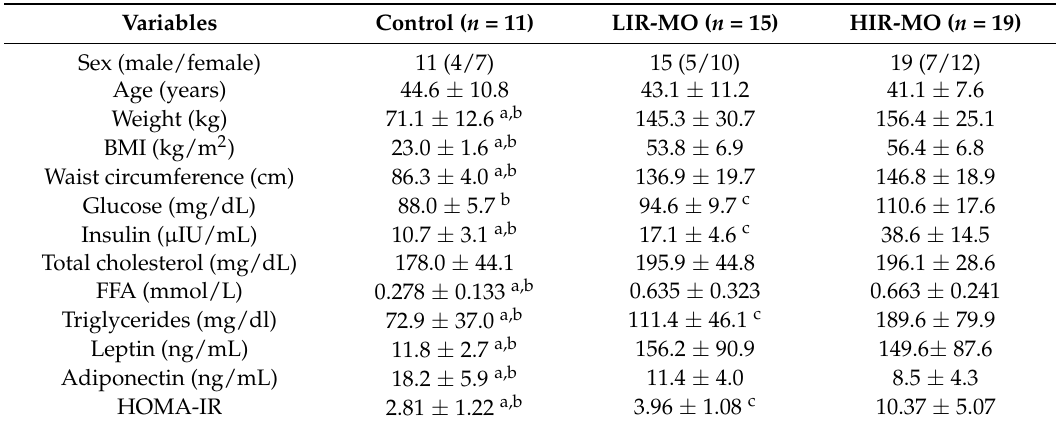
Table 1. Baseline anthropometric and biochemical variables of the study population.